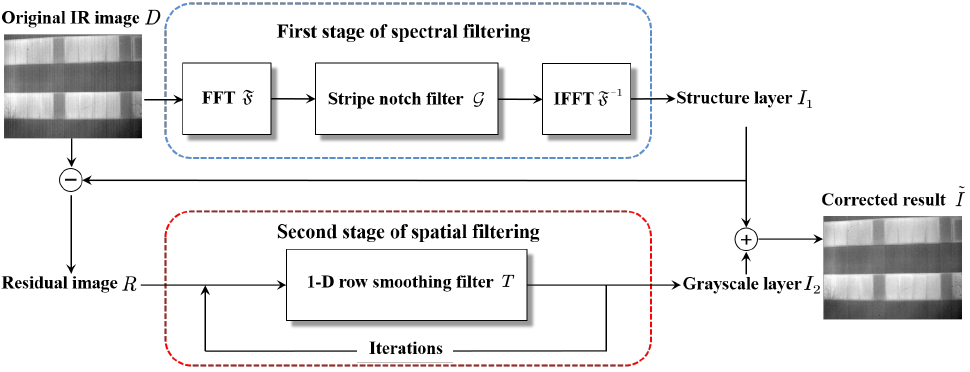
Figure 3. Framework of the proposed